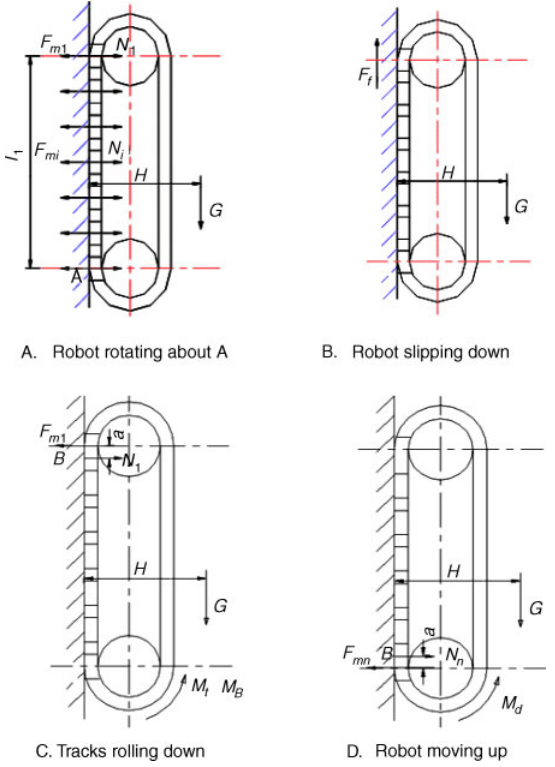
Figure 3 Forces and torques under different